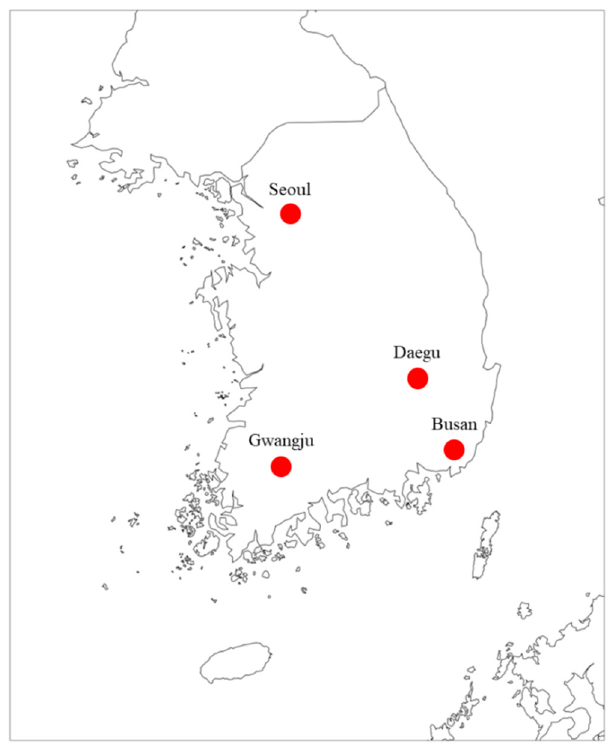
Figure 3. Four major cities selected for forecast performance evaluation.